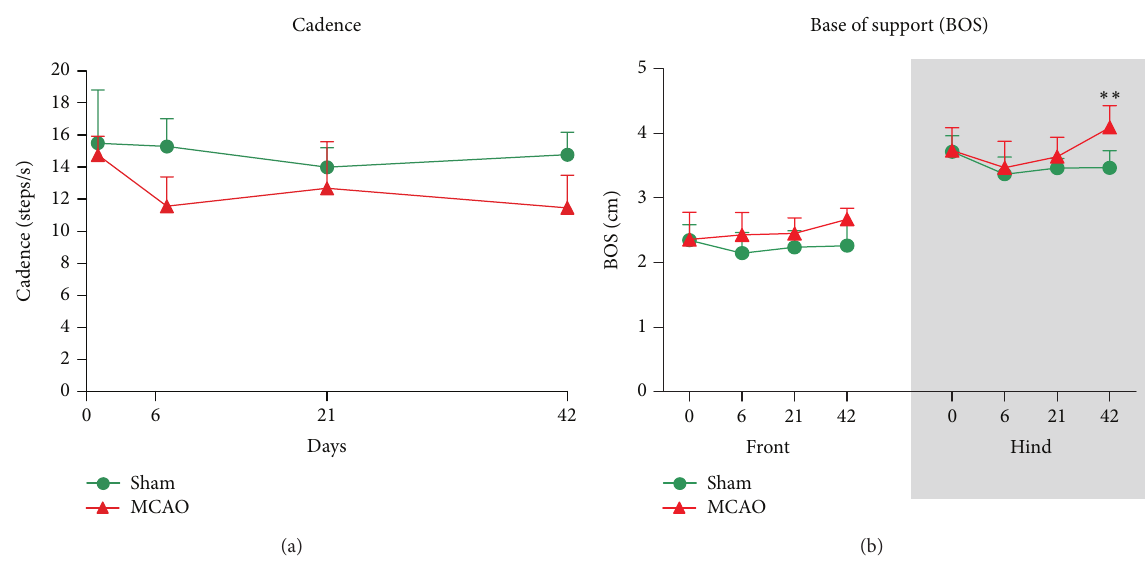
Figure 3: Focal cerebral ischemia significantly affected cadence and base of support (BOS). (a) MCAO animals showed a decreased number of steps per second (cadence) when walking along the CatWalk runway at postoperative days 6 and 42. (b) Ischemic animals showed significantly larger hindlimb BOS at postoperative day 42. All values are given as mean ± SD. Statistics: ∗∗ 𝑃 < 0.01 versus sham-operated